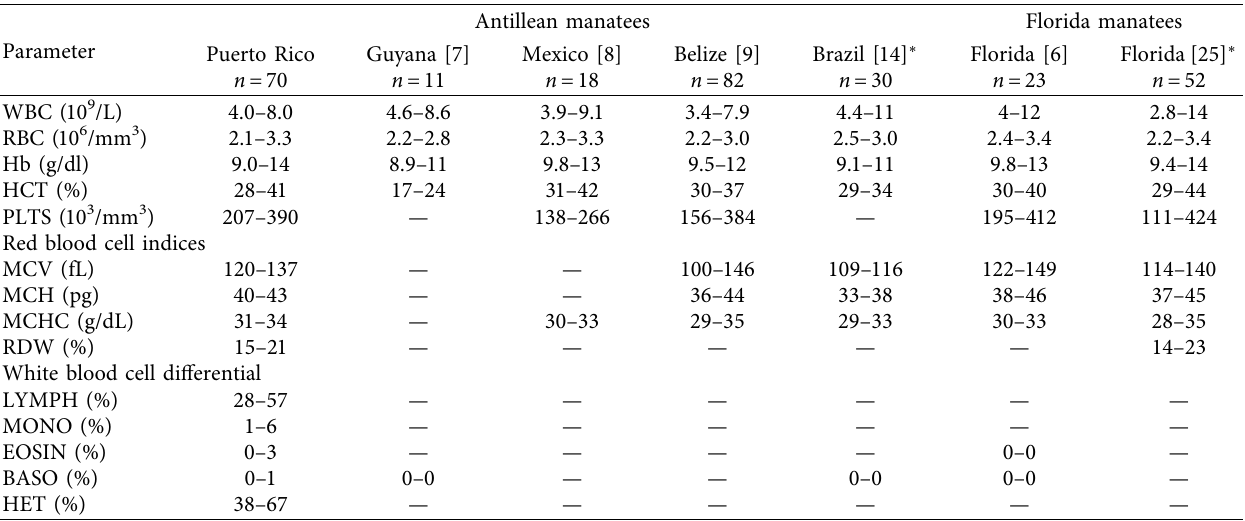
Table 6: Hematology reference intervals for West Indian manatees from Puerto Rico, Guyana, Mexico, Belize, Brazil, and Florida. Puerto Rico values included all samples (calves, subadults, and adults). Abbreviations for parameters are detailed in the materials and methods section. Columns with an asterisk ( ∗ ) signify that the range values are minimum and